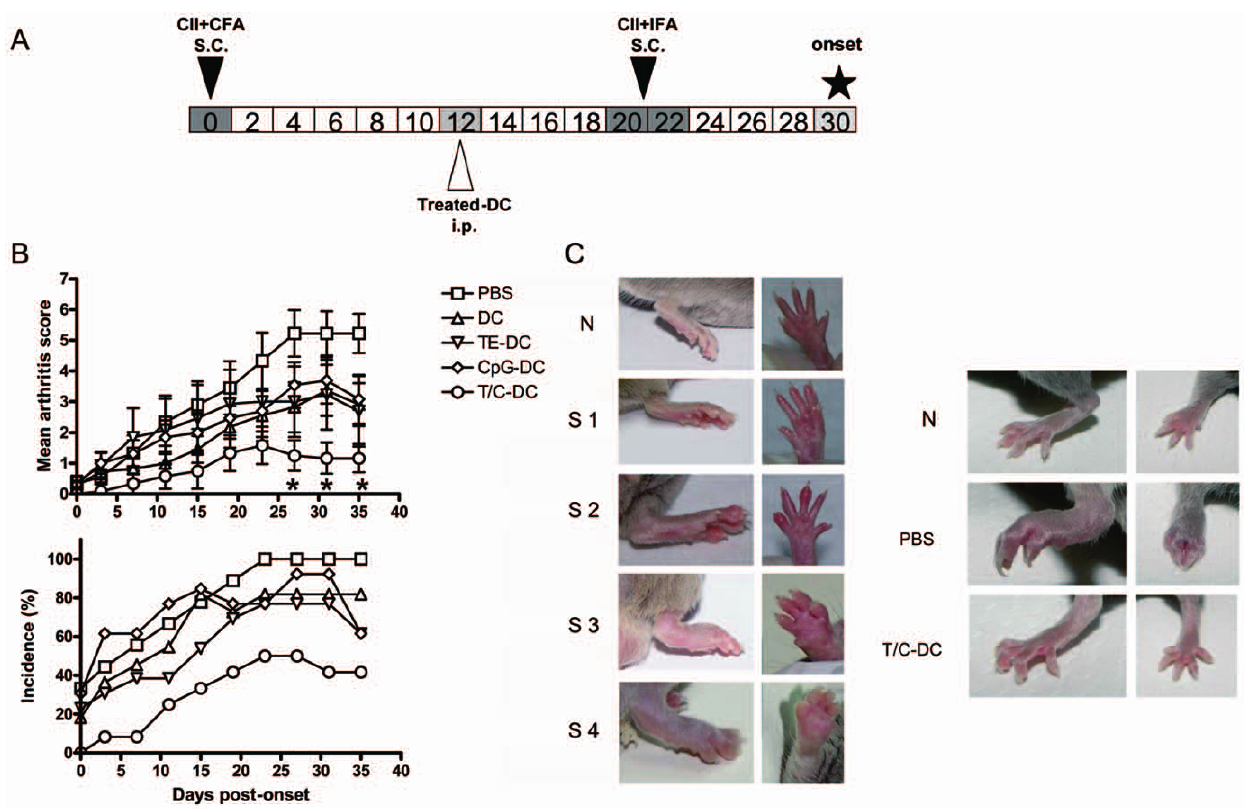
Figure 2. Diminished severity of CIA after treatment with CII pulsed T/C-DC. A) Scheme representing the experimental protocol followed, which is described in material and methods. B) The arthritis severity and incidence were assessed by clinical scoring from 0 to 35 days of onset in PBS (control), or in medium, TE, CpG and T/C-treated DC recipient mice. Values in arthritis score are the mean 6 SEM of 12–15 mice per group and the incidence shows data compiled from 3 independent experiments, * P , 0.05 for T/C-DC versus PBS on days 27, 31 and 35. C) Photographs show representative examples of the paw swelling in mice with different clinical scores (left panel), and normal, PBS and T/C-DC groups (right panel). N: normal, S: